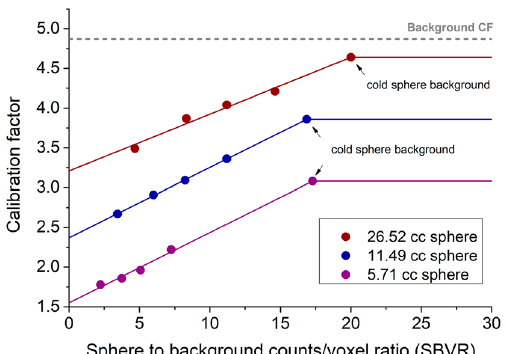
Fig. 4 CF values in cps/MBq versus SBVR calibration curves for the 26.52 (red curve), 11.49 (blue curve) and 5.71 cc (purple curve) spheres. The CFs data obtained from several NEMA Cal. 2 acquisitions (dots) were interpolated using a simple a linear regression fit. The “cold background” points were obtained from the point of intersection between the linear curve and the cold background CF value for each of the three spheres. The cold background CF value represents the maximum value of the CF for every sphere. The horizontal gray dashed line with a value of 4.87 represents the background CF for large